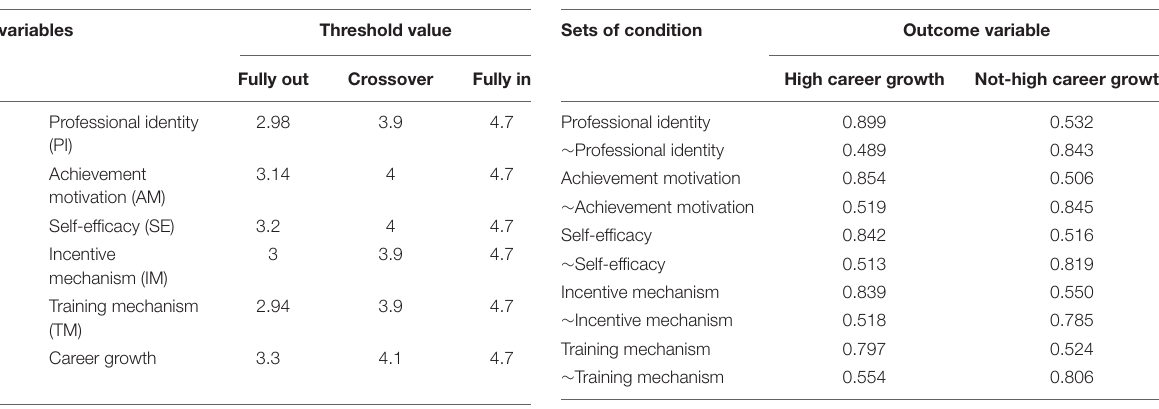
TABLE 3 | Fuzzy set calibrations. TABLE 4 | Analysis of necessary conditions for GPs career growth in FsQCA.